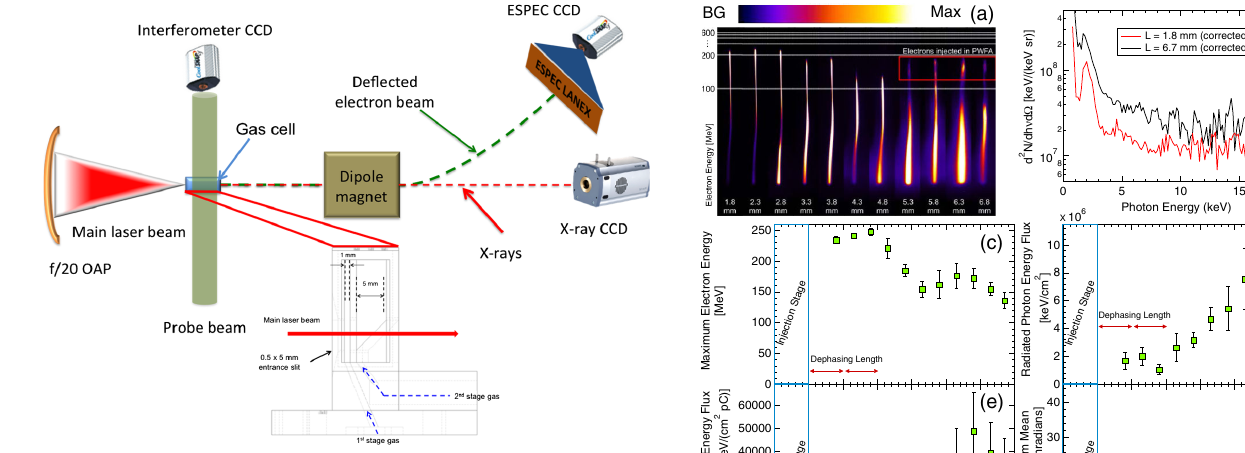
FIG. 1. Schematic of the experimental setup. The main beam is focused using an f= 20 off-axis paraboloid onto a two-stage gas cell. Electrons exiting the gas cell were swept by a dipole magnet and imaged using a LANEX screen in conjunction with a CCD camera. X rays were measured 2.5 m downstream with an x-ray camera. A two-stage, variable length gas cell is zoomed in. The acceleration length can be changed by adjusting the vertical height of the gas cell with respect to the main laser beam (as a result of the 45 degree incline in the second stage). The dashed arrows show the path of gas flow into the cell.